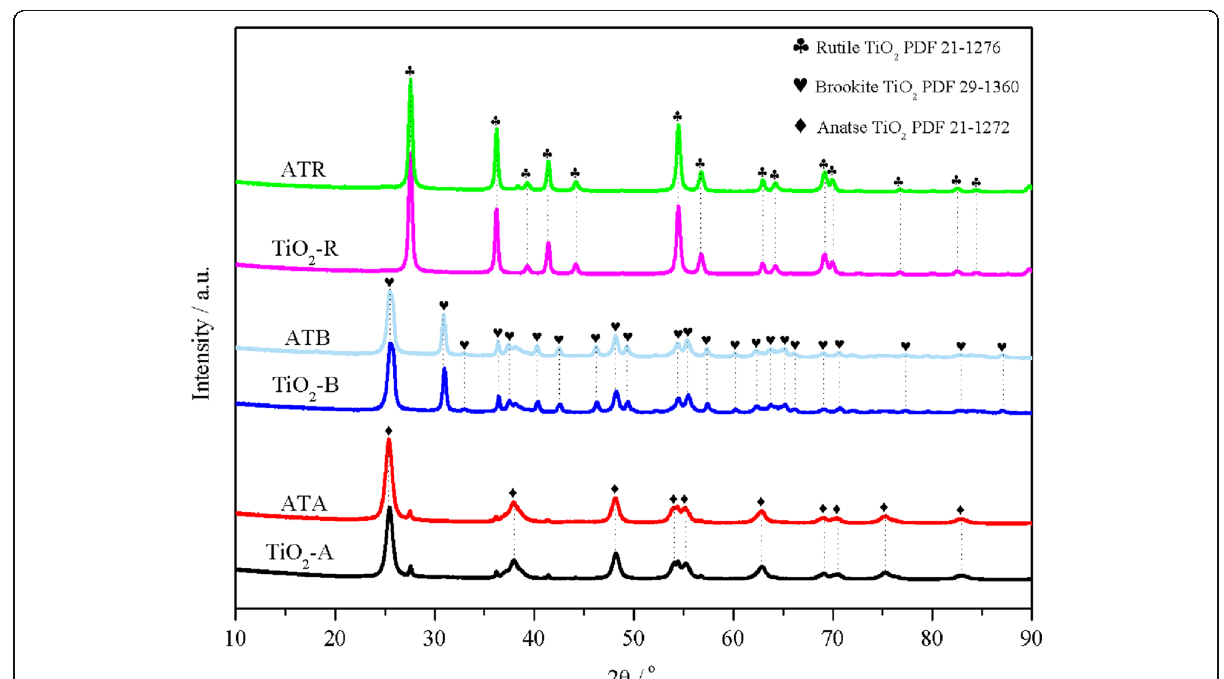
Fig. 1 XRD patterns of the TiO 2 -A, ATA, TiO 2 -B, ATB, TiO 2 -R, and ATR